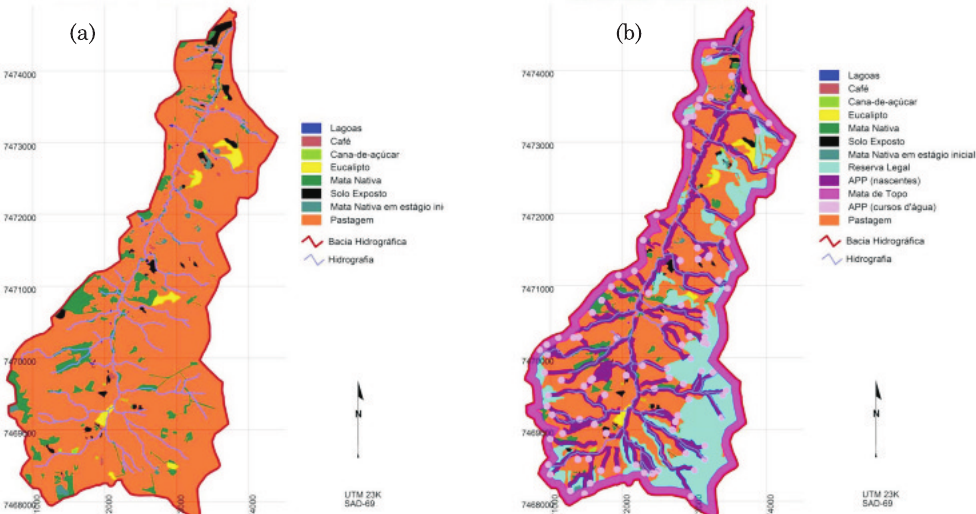
Figura 3. Tipos de uso do solo na sub-bacia das Posses, antes (a) e após (b) a implantação do projeto “Conservador das Águas”.